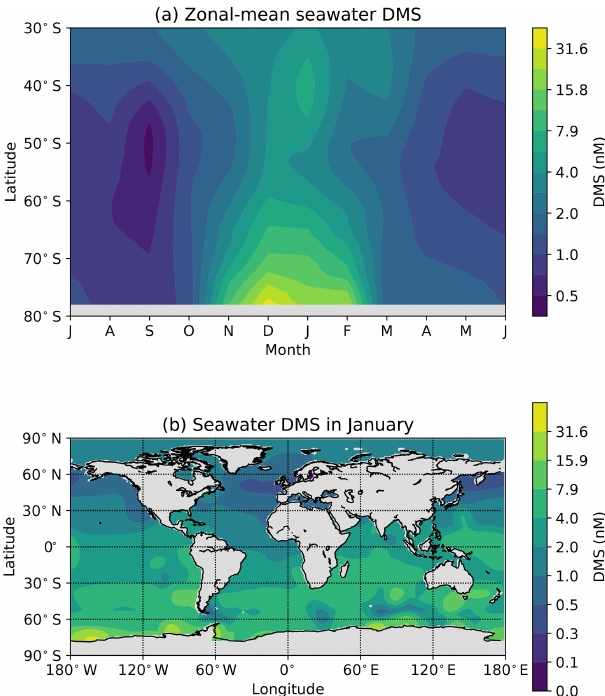
Figure 5. Seawater DMS concentrations from the Lana et al. (2011) climatology used as input to HadGEM3-GA7.1-mod shown for (a) the Southern Ocean as a zonal mean and (b) globally for Jan-